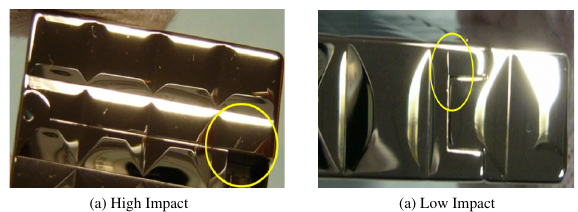
Fig. 13. Law of continuity: example of the impact of the